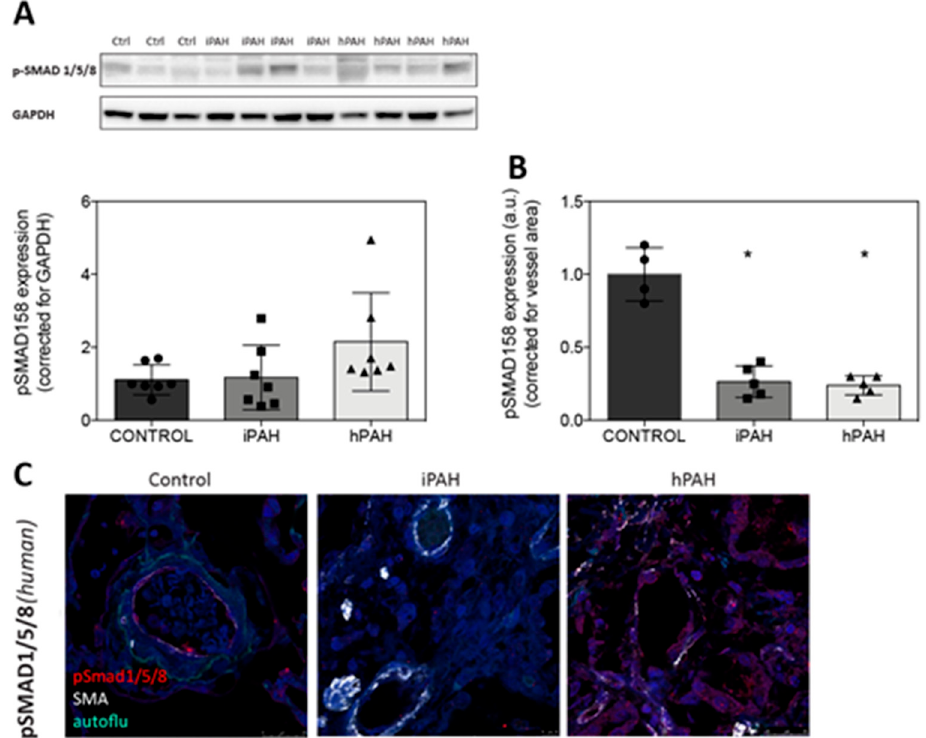
Figure 2. Analysis of Smad 1 / 5 / 8 / phosphorylation in the whole lung homogenates. ( A ): pSmad 1 / 5 / 8 in the whole lung homogenates. ( B ): pSmad 1 / 5 / 8 expression corrected for the vessel area. ( C ): Typical examples of the vessels are shown. Red = pSmad 1 / 5 / 8; white = smooth-muscle-actin; blue = nuclei. autoflu = autofluroscence. Scale = 10 µ m. * = p < 0.05.